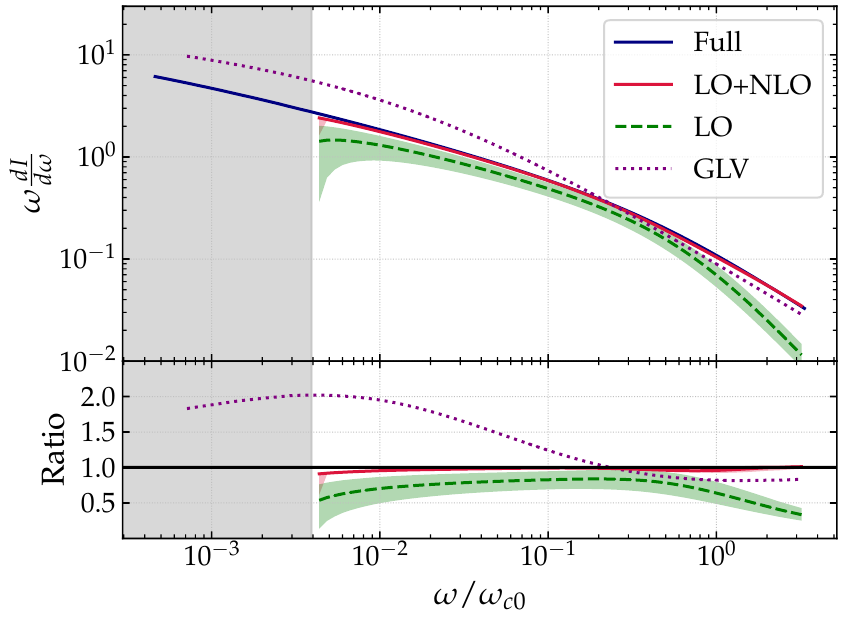
Figure 2 . Comparison between the energy spectrum computed with GLV (dotted, purple), the IOE at LO (dashed, green), at LO+NLO (solid, red) and the all-order spectrum (solid, navy) as computed in [33]. The ratio to the full solution is presented in the bottom panels. The uncertainty band arises from variations in the matching scale and the gray region indicates the regime in which eq. (2.42) does not have a solution. The parameters used are identical to those of figure 1 and ω c 0 ≡ ˆ q 0 L 2